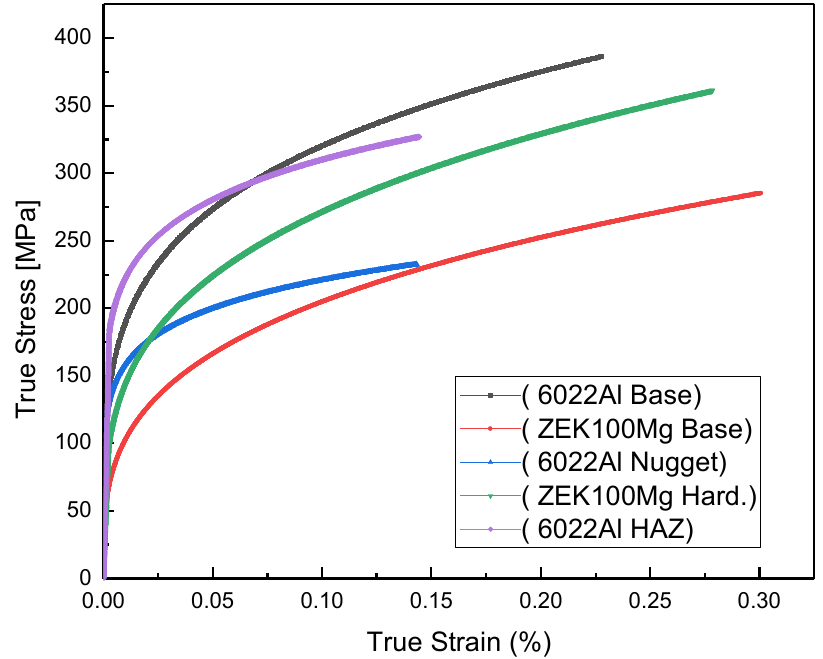
Figure 17. True stress–strain curves from nanoindentation testing.